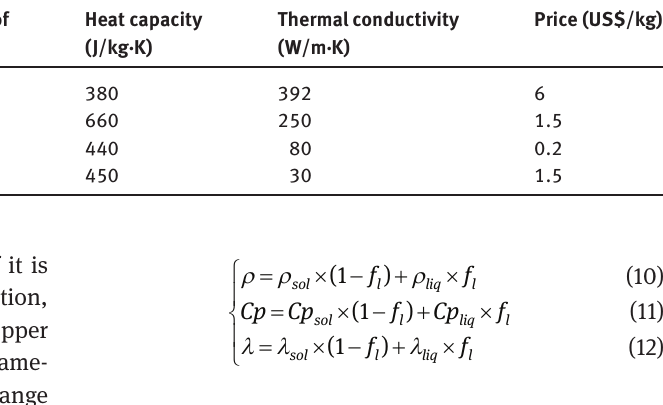
Table 2: Main properties of metals retained for the investigation Material